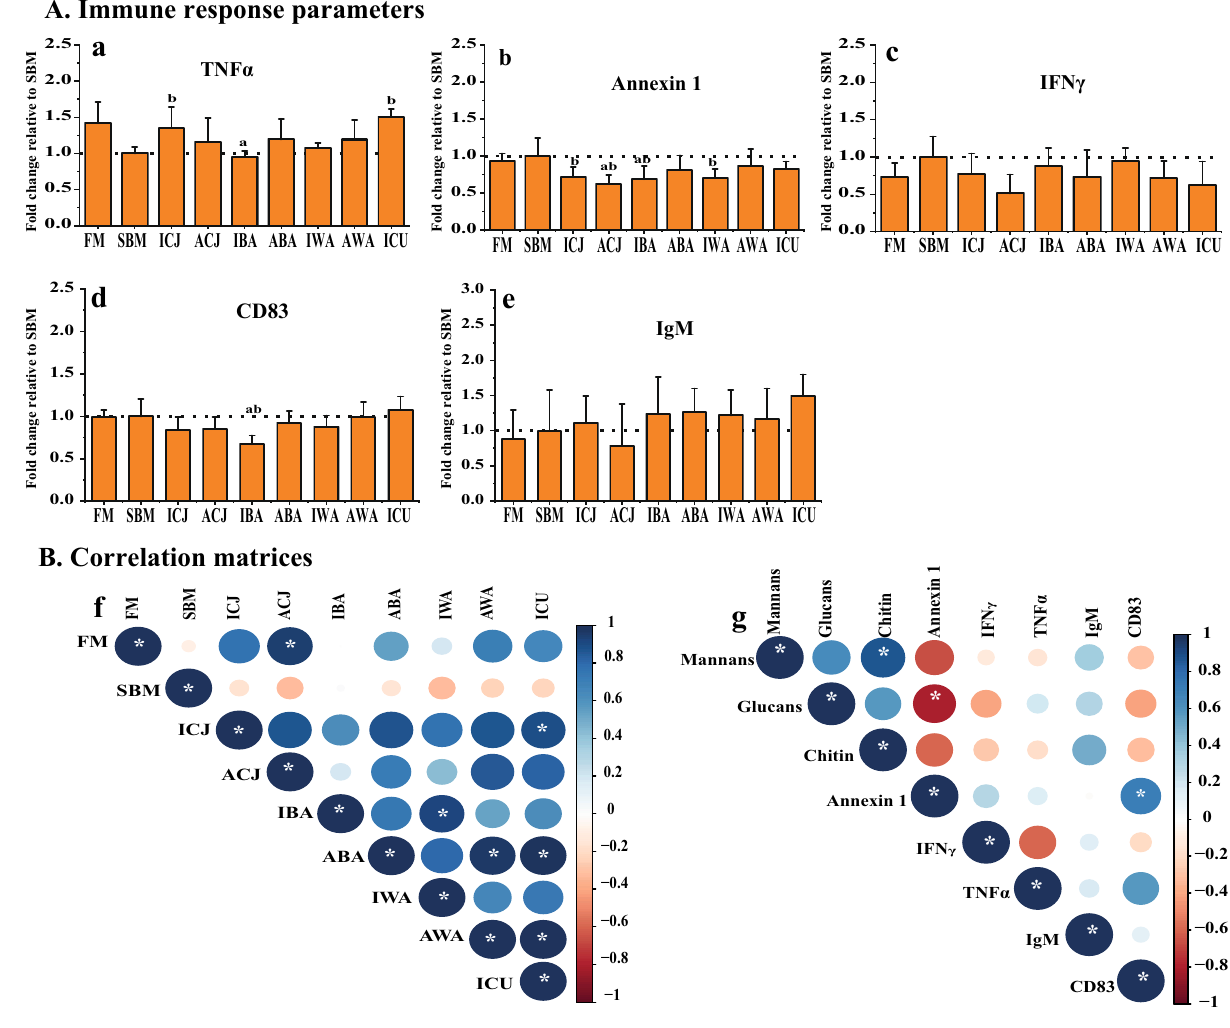
Figure 2. Immune responses ( A ) of Atlantic salmon fry fed soybean meal-based diets with yeasts. Protein expression values for distal intestine ( a – e ) were obtained by indirect ELISA and are expressed as fold-change relative to the value obtained for the SBM group. Correlation matrices between the immune markers, and calculated mannan, glucan and chitin intake are shown in panel ( B ). Graph ( f ) shows the correlation between all the experimental diets using five immunological markers ( TNFα , Annexin 1 , IFNγ, CD83 and IgM ). Graph ( g ) shows the correlation between the calculated average daily intake of glucan, mannan and chitin, and the previously mentioned immune markers. The average daily intake of glucans, mannans and chitin were calculated from average dry matter daily feed intake and the composition of the respective cell wall components in each yeast (Table 1). For the correlation matrices, positive correlations are displayed in blue and negative correlations in red color; both the color intensity and the size of the circle are proportional to the correlation coefficients. The diets are: FM -fishmeal-based; SBM -Soybean meal-based; 7 other diets containing 40% SBM and 5% of inactivated Cyberlindnera jadinii ( ICJ ), autolyzed C. jadinii ( ACJ ), inactivated Blastobotrys adeninivorans ( IBA ), autolyzed B. adeninivorans ( ABA ), inactivated Wickerhamomyces anomalus ( IWA ), autolyzed W. anomalus ( AWA ) and ref- C. jadinii ( ICU ). The letters a and b directly above the bar charts ( a – e ) denote treatment(s) with a statistical difference ( P < 0.05 ) compared to the fishmeal and soybean meal control groups, respectively. Correlations ( f , g ) with significant values at P < 0.05 are shown with *